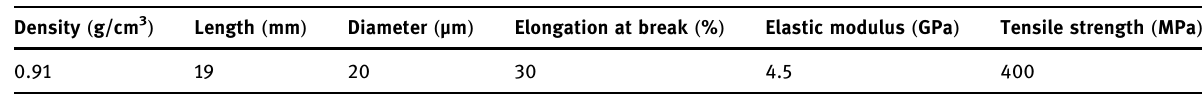
Table 4: Technical indicators of pp fi ber Density ( g/cm 3